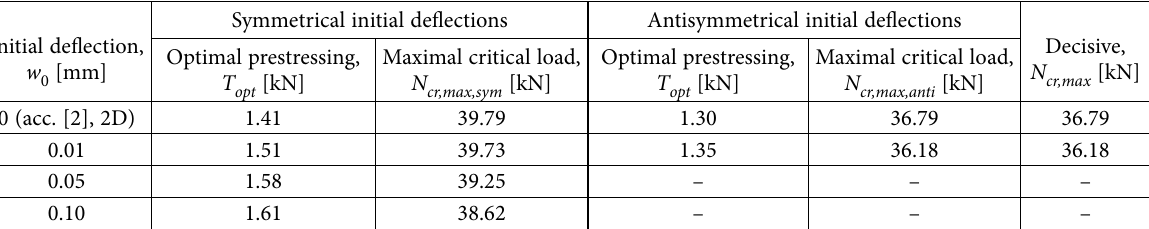
Table 1. Maximal critical loads and optimal prestressing